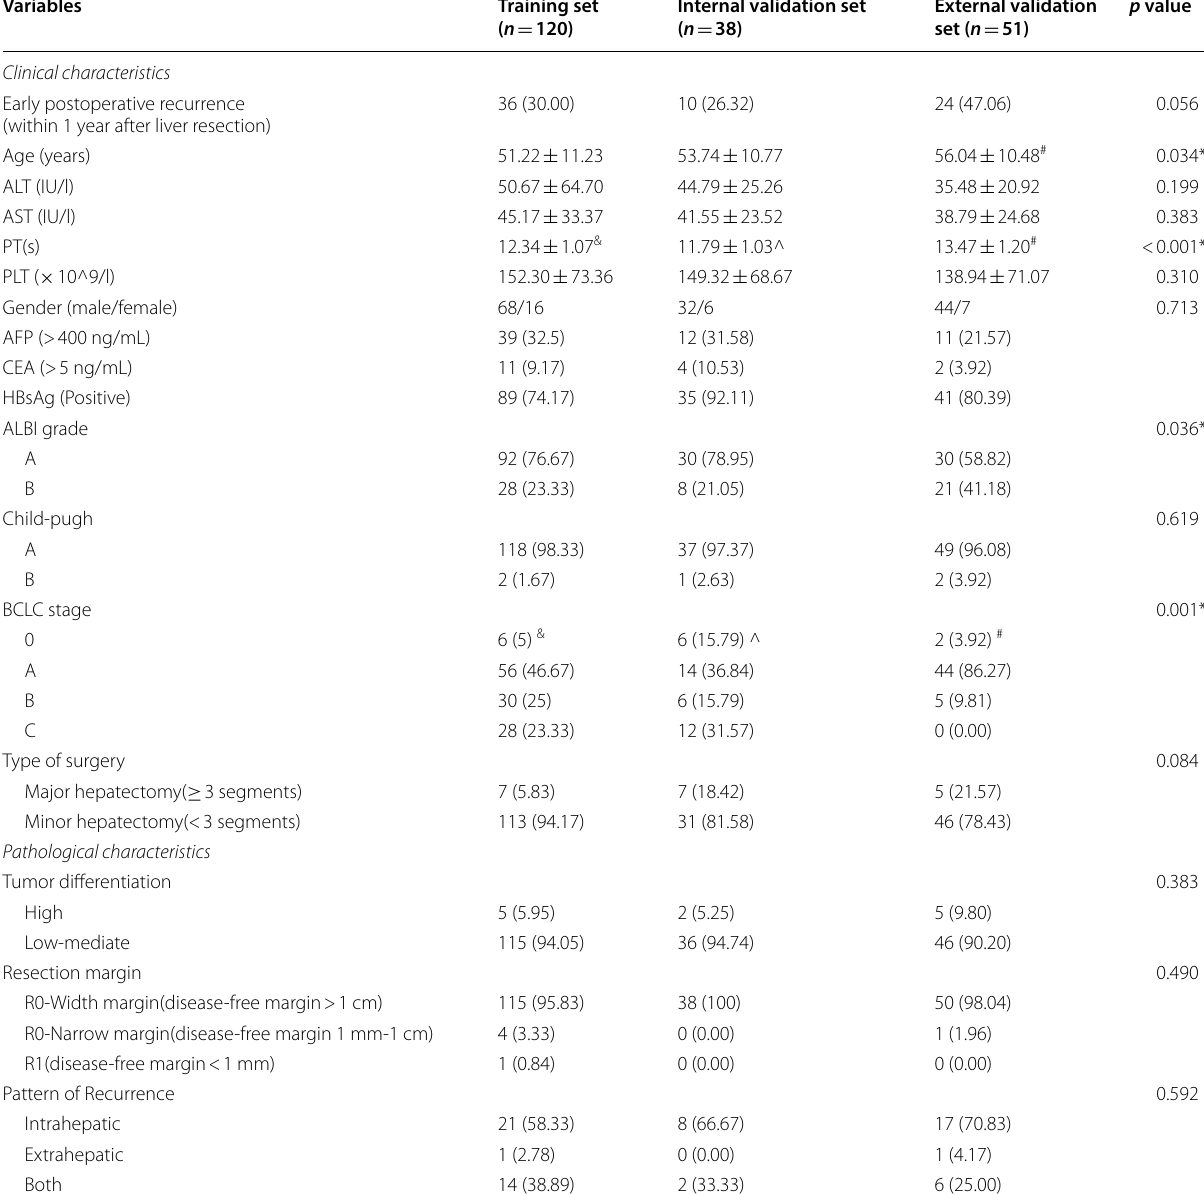
Table 1 Clinicopathological characteristics of the training, internal validation and external validation